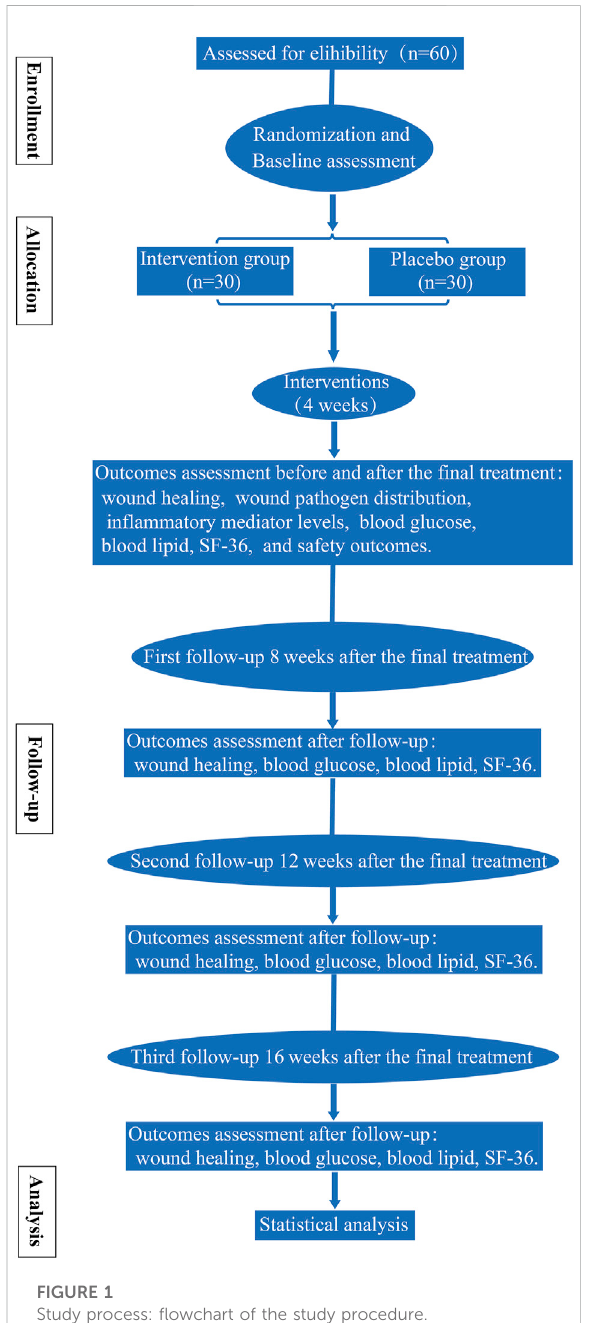
FIGURE 1 Study process: fl owchart of the study